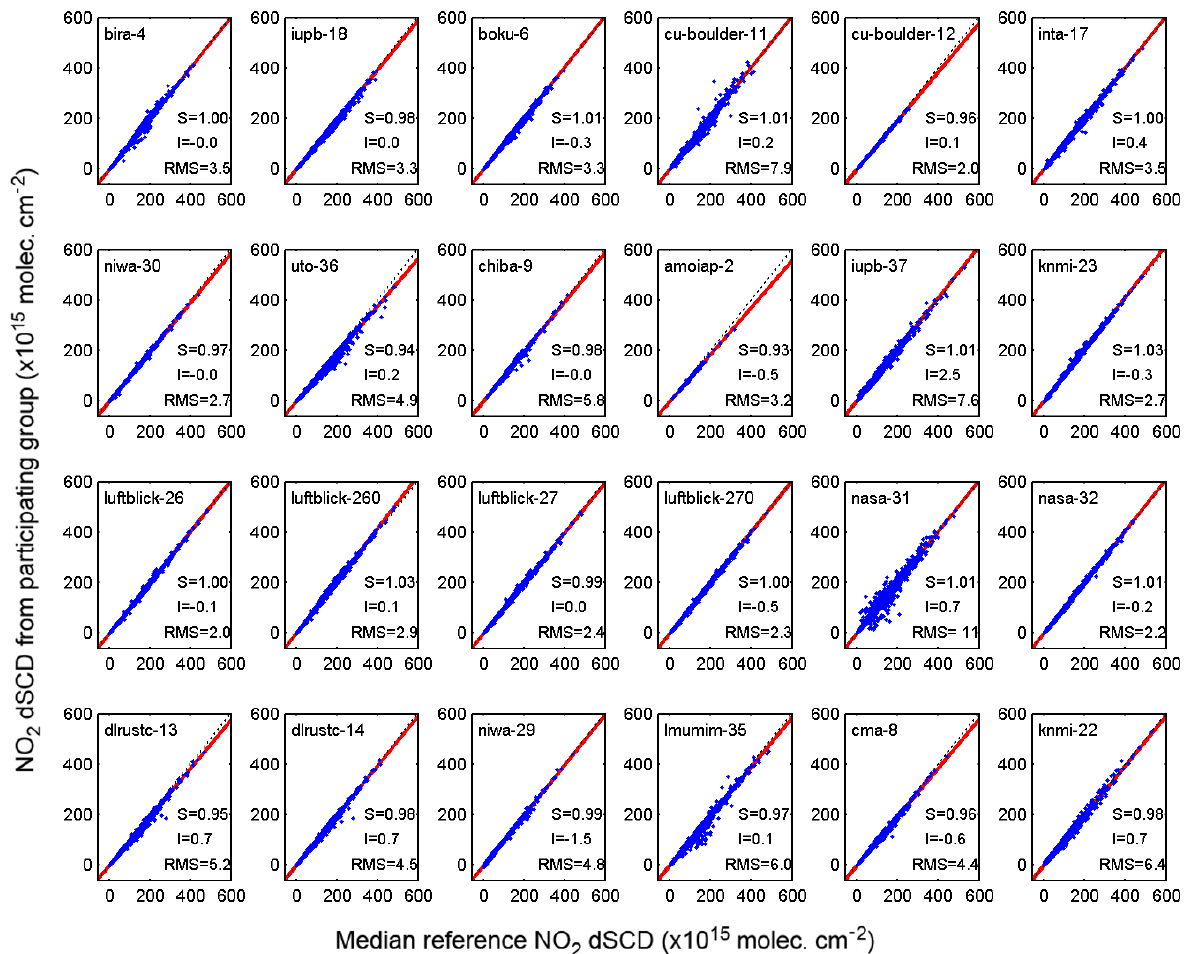
Figure 10. Regression analysis for NO 2 dSCDs (measured in the visible wavelength region) for each instrument which was measuring NO 2 in this wavelength region plotted against median values for the whole semi-blind phase, including all viewing and azimuth angles (blue crosses). The linear regression line is displayed as a red line, the 1-to-1 line as a reference as a dotted line. Instruments are identified with their affiliation and instrument ID number. S is the slope of the regression, I the intercept and rms the root-mean-square of the regression